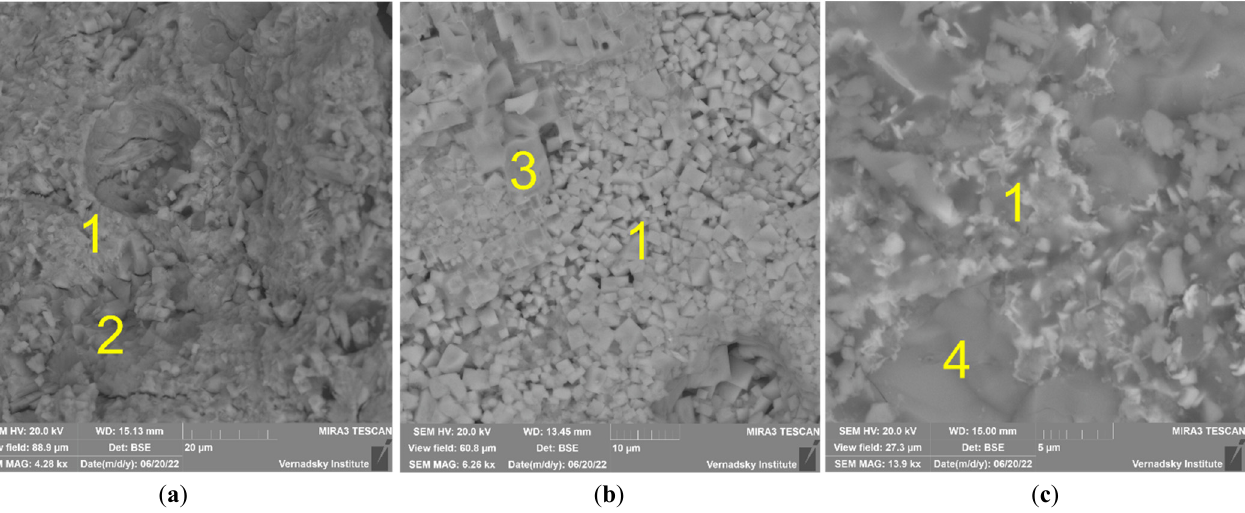
Figure 5. SEM image of NAFP matrix samples synthesized at 550 ( a ), 650 ( b ) and 750 °C ( c ), where 1, 2, 3 and 4 are phosphate phases. Table 4. Average data of elemental composition (wt%) of the NAFP matrix according to SEM/EDS data.